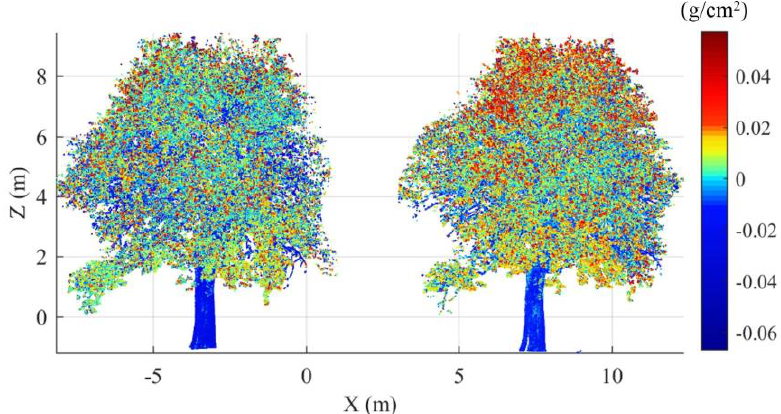
Figure 5. EWT point-clouds of the Swedish whitebeam tree in August (left) and in October (right).